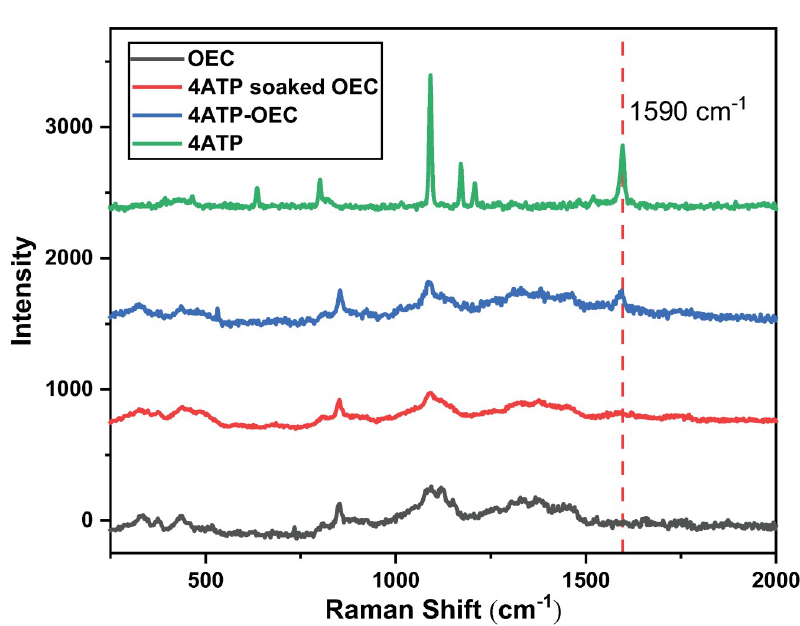
Fig 2. The Raman spectra of samples with different Raman tag binding methods. The Raman spectra collected from OEC, 4ATP soaked OEC, 4ATP-OEC, and bulk 4ATP